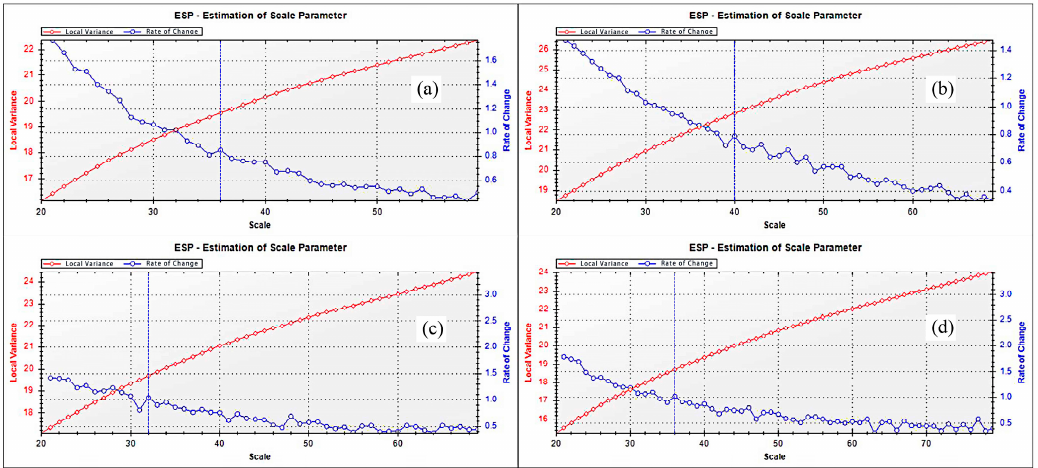
Figure 5. The optimal segmentation scale results of the sample areas calculated by the ESP tool. ( a ) local variance results for sample a relative to the rate of change; ( b ) local variance results for sample b relative to the rate of change; ( c ) local variance results for sample c relative to the rate of change; ( d ) local variance results for sample d relative to the rate of change.